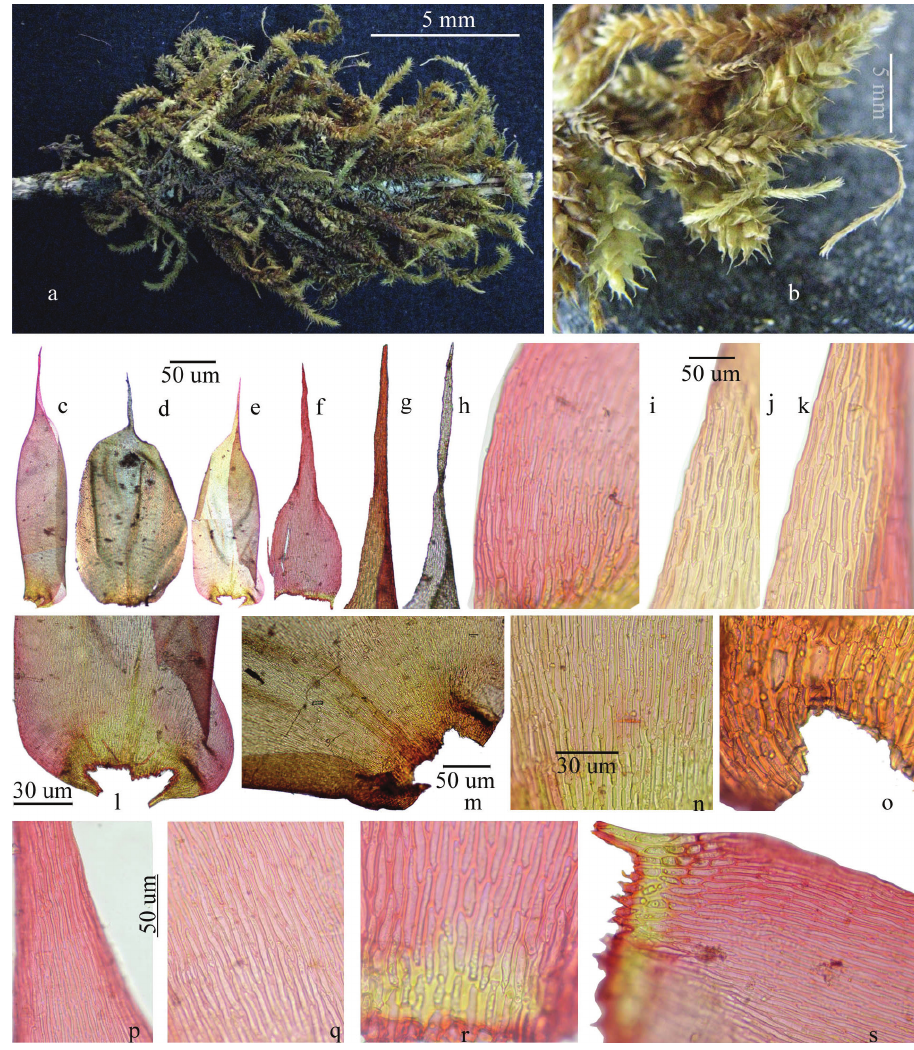
Figure 1. Symphysodontella madhusoodananii, a–b habit c–e leaf at main stem f leaf at flagella g–h leaf tip i basal marginal cells j–k leaf margin at tip l–m leaf insertion cells n leaf middle cells o basal cells enlarged p leaf tip cells q leaf middle cells r–s leaf basal cells. complanate, plicate, tip tortuose in some leaves, long apiculate, margin denticulate at tip, recurved below, cells at acumen elongate linear, up to 50 µm long, thick walled above, middle cells 60–70 µm × 20–25 µm, less thick but with porose walls below, 35–45 µm × 28–35 µm, costa and cells at stem attachment yellowish brown, alar cells not prominently differentiated in size but with deep brown, rectangular porose cells, 40–45 × 25–35 µm, porose in some cells, leaf insertion to the stem is U shaped; cells at flagella almost same size and shape; sporophyte not seen (Figure 1